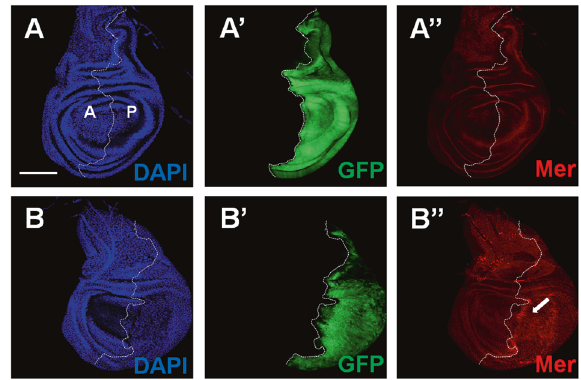
Fig. 4 Downregulation of Mnat9 increases Mer protein level. Wing discs were stained for DAPI, GFP, and Mer, as indicated. A – A ″ Control wing with en > GFP . B – B ″ Wing discs with en > Mnat9 RNAi, GFP , and Dcr-2 . The posterior en domain is shown by GFP staining ( B ′ ). Mnat9 downregulation by en-Gal4 increases Mer protein level in the posterior part of the wing disc ( B ″ arrow). Scale bar: 100 μ m. Dashed line: anterior (A) – posterior boundary